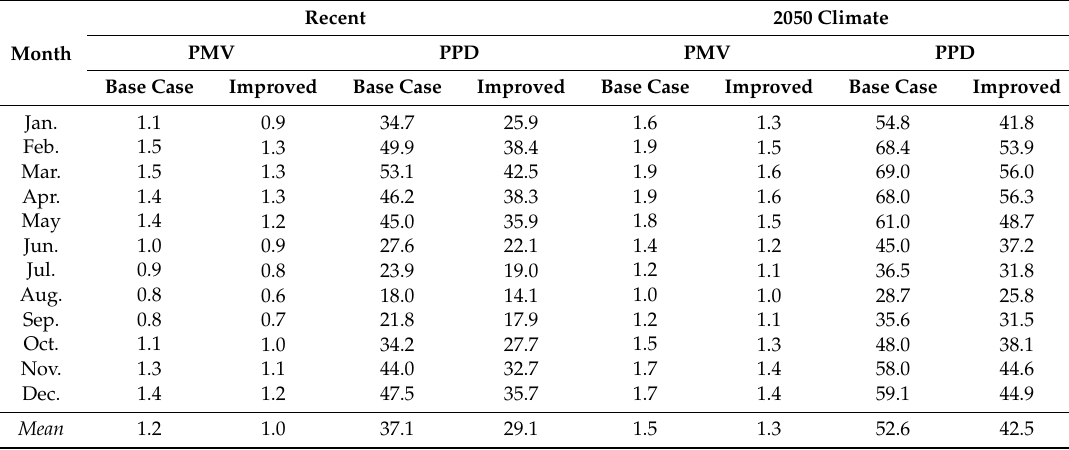
Table 11. Predicted mean vote (PMV) and predicted percentage dissatisfied (PPD) at 1% occupant for the building as-built and with improvement strategies with the recent and 2050 climate